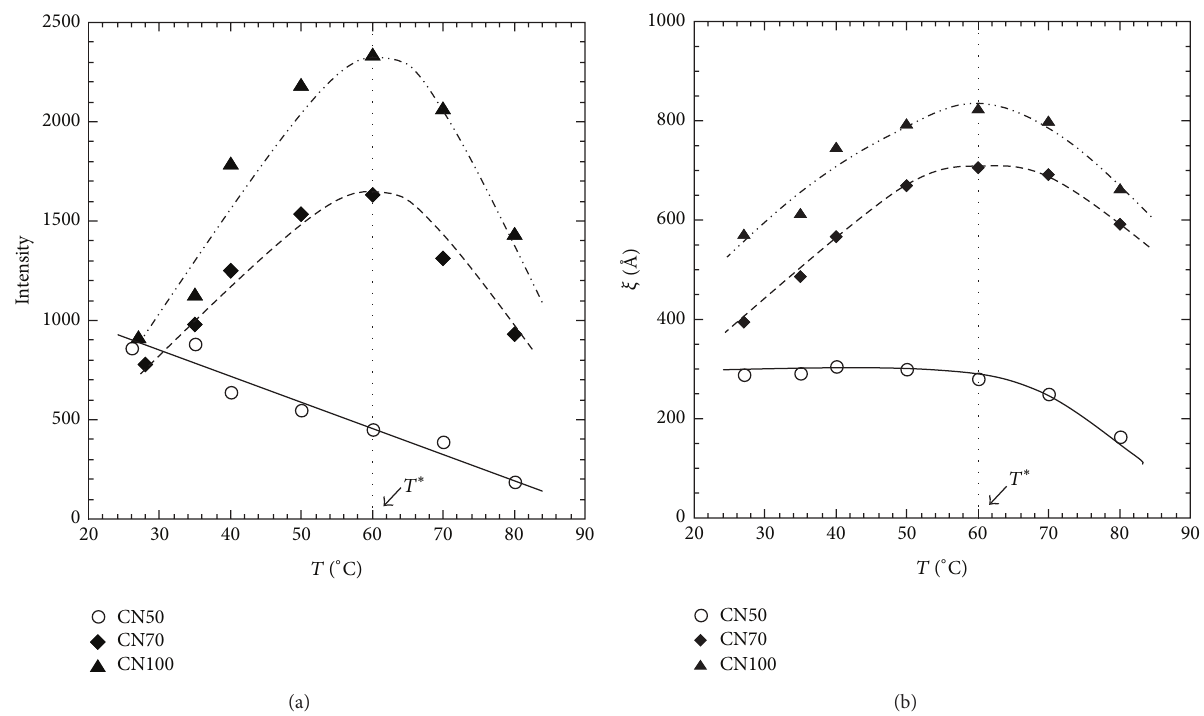
Figure 9: The small angle peak intensities (a) and 𝜉 , the correlation length of the smectic layers calculated from the 2 𝜃 profile, line 3 in Figure 7, are plotted as a function of temperature for the CN50, CN70, and CN100 samples. The solid and dotted lines are guides for the eye. The maximum peak intensities (a) and the maximum correlation length (b) for CN70 and CN100 are observed at 𝑇 ∗ ∼ 60 ∘